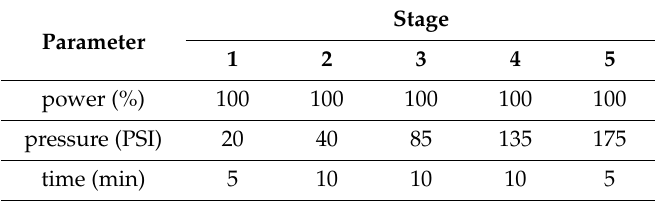
Table 2. Operating parameters for the microwave oven (CEM, MDS